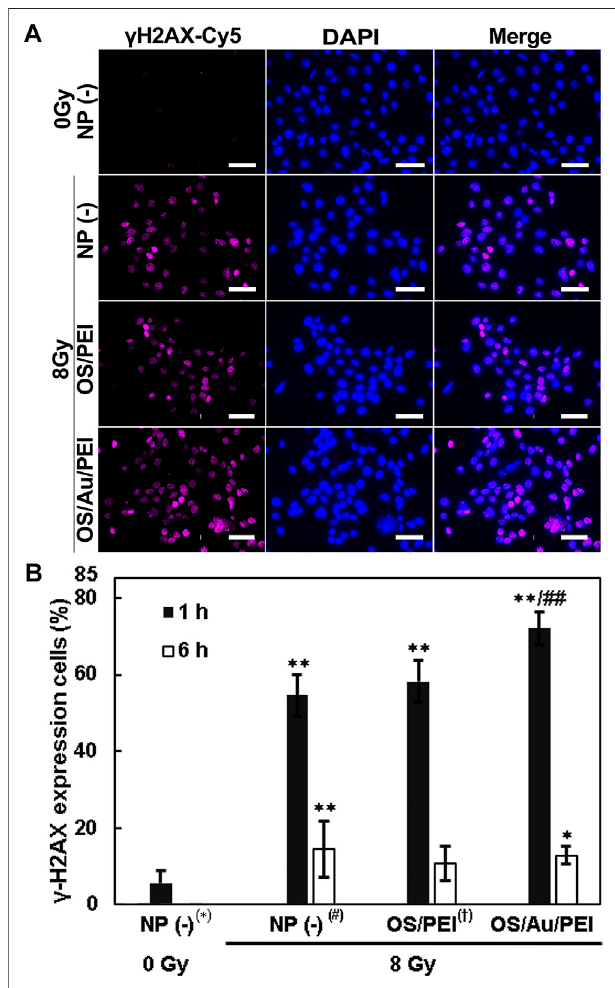
FIGURE 5| (A) FM images of4T1 cells stained blue with DAPI (indicates the cell nucleus) and stained magentawith Cy5 (indicates the γ -H2AX) treated with 30 μ g ml − 1 of NP (-), OS, OS/PEI, and OS/Au/PEI with X-ray irradiation after 1 h. Scale bar = 50 μ m. (B) γ -H2AX expression in 4T1 cells treated with 30 μ g ml − 1 of NP (-), OS, OS/PEI, and OS/Au/PEI with X-ray irradiation after 1 and 6 h * Signi fi cantly different from the 4T1 cells treated with 0 Gy NP (-). # Signi fi cantly different from the 4T1 cells treated with 8 Gy NP (-). † Signi fi cantly different from the 4T1 cells treated with 8 Gy OS/PEI.